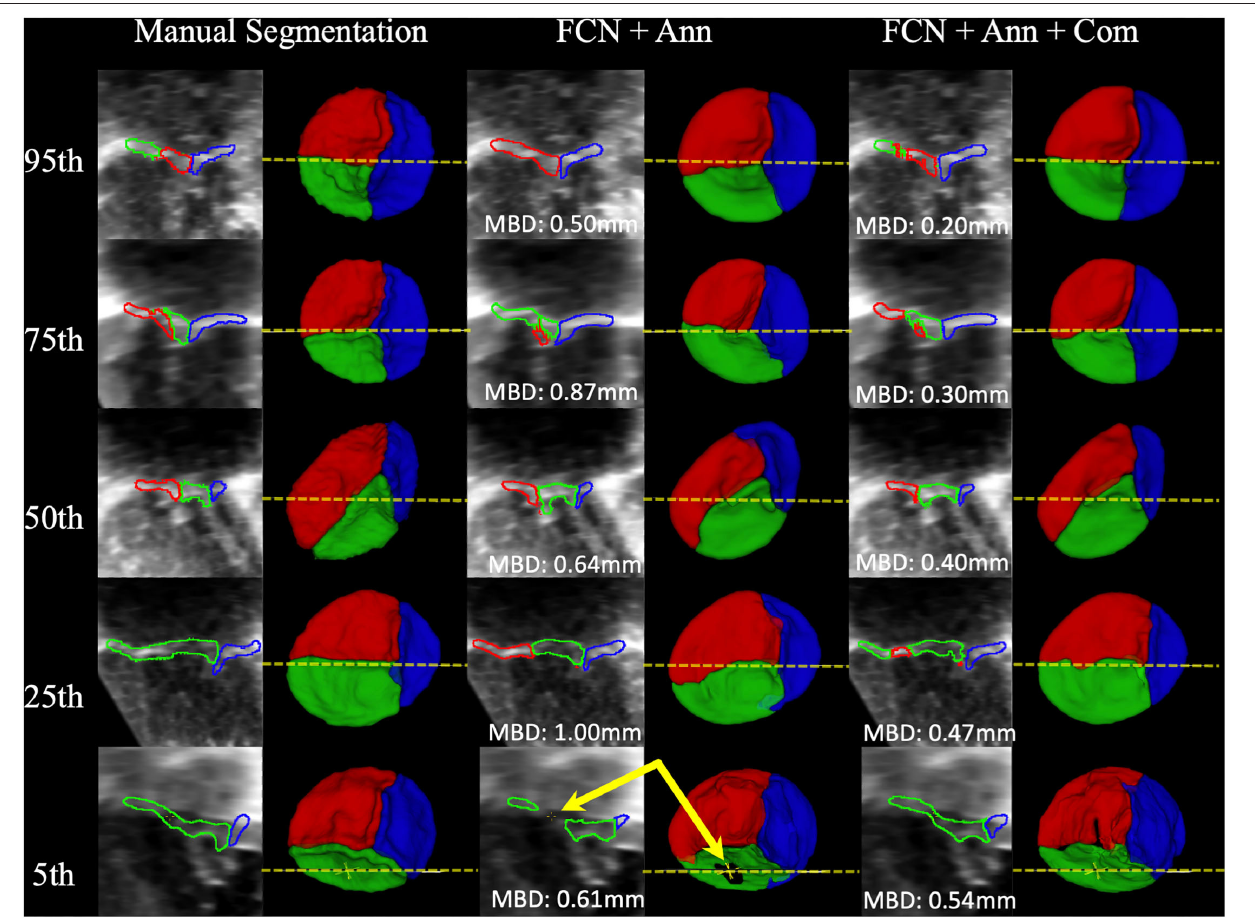
FIGURE 7 | Examples of Segmentations predicted by the FCN. From Left to Right : 2D view of the MS frame (including MBD displayed at the bottom) and 3D segmentation model (ventricular view including indicator of 2D slice location) for Manual Segmentation, FCN + Annulus (Ann), and FCN + Ann + Commissures (Com). From Top to Bottom : 95th, 75th, 50th, 25th, and 5th percentile for MBD based on the best ranked CSP FCN with Ann + Com. The bottom row (5th percentile) shows an example of ultrasound signal dropout (indicated by arrows) that influenced the inferred segmentation using the annular curve only relative to the manual segmentation in which the user enforced the topology. When using the commissural landmarks in addition to the annular curve as FCN inputs, individual leaflet boundary detection improved and FCN segmentation was less sensitive to signal